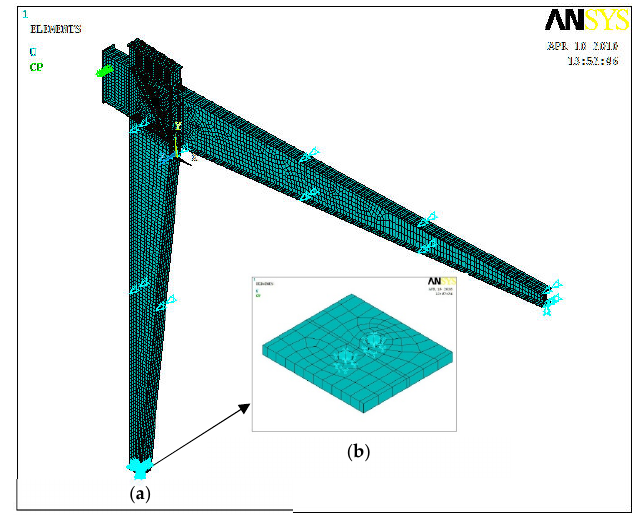
Figure 15. ANSYS model. ( a ) SGFs model; ( b ) Model of column base.